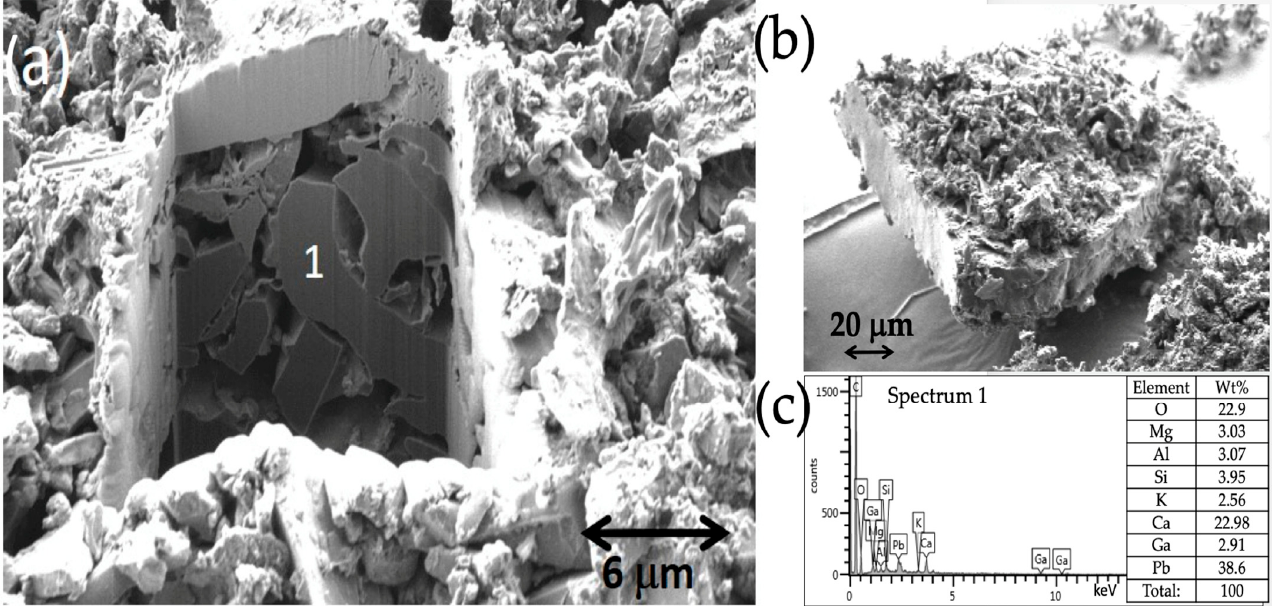
Figure 11. ( a ) Secondary electron image of the trench performed in the varnish layer of sample J-4; ( b ) secondary electron image of the sample; ( c ) X-ray spectrum acquired in a point (1) of the cross-section.